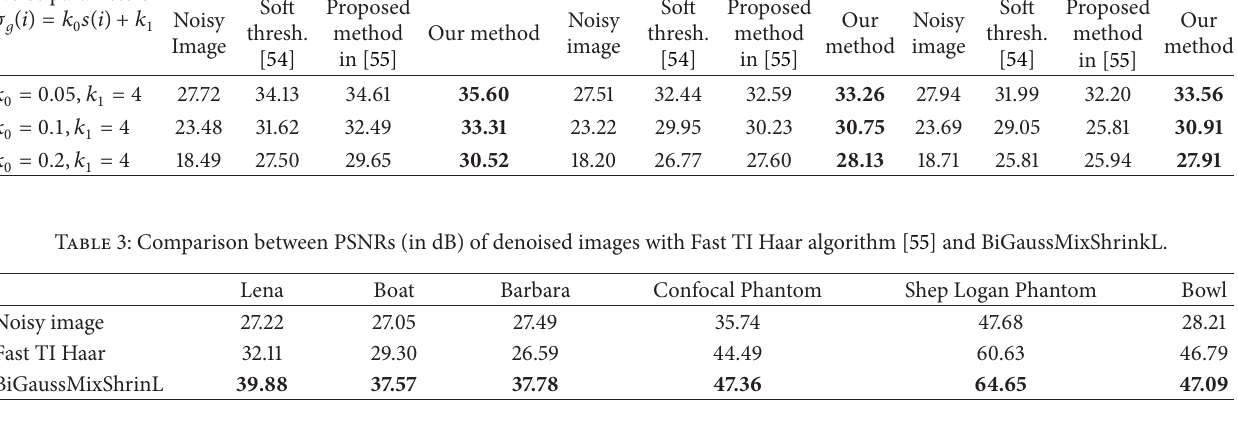
Table 2: PSNR (in dB) values of test images for different nonstationary noise levels. Noise parameters (𝑖) = 𝑘 𝑠(𝑖) + 𝑘 𝜎 𝑔 0 1